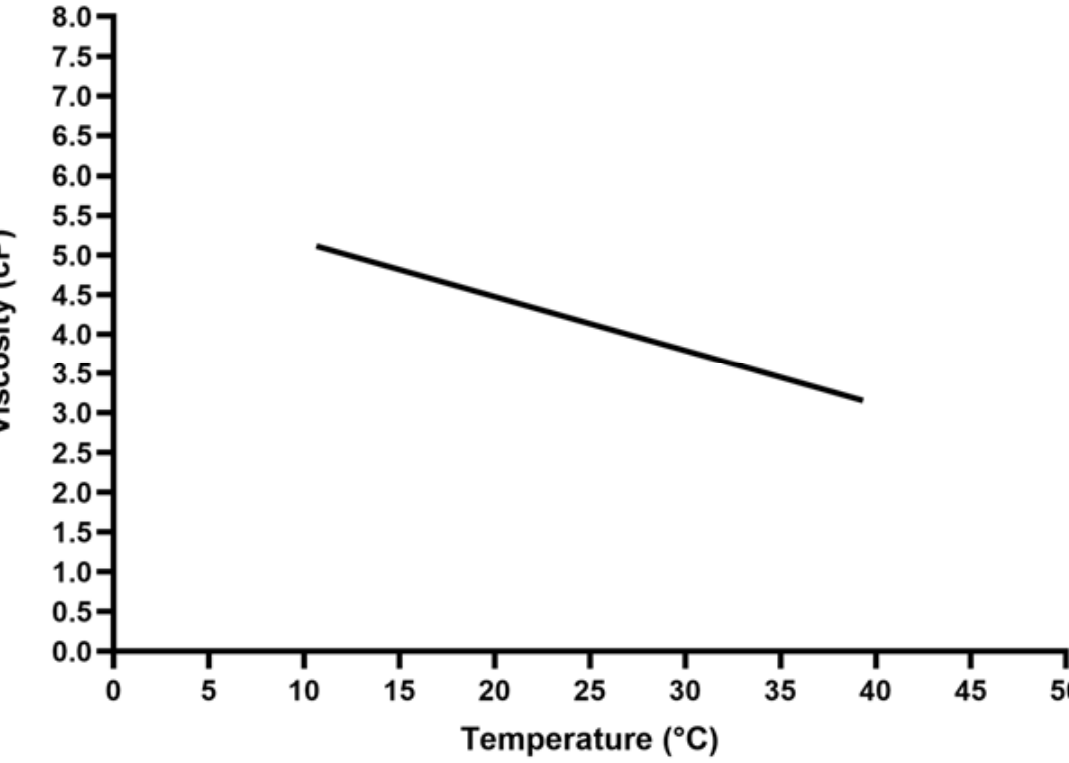
Figure 2. Relationship between temperature and viscosity .